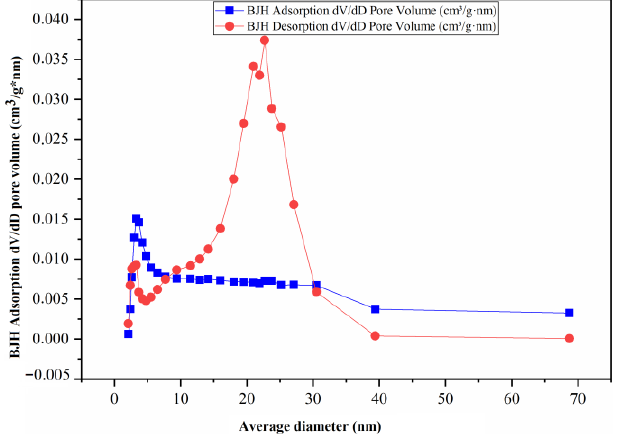
Figure 6. BJH Adsorption and desorption dV/dD pore volume of catalyst - 2.